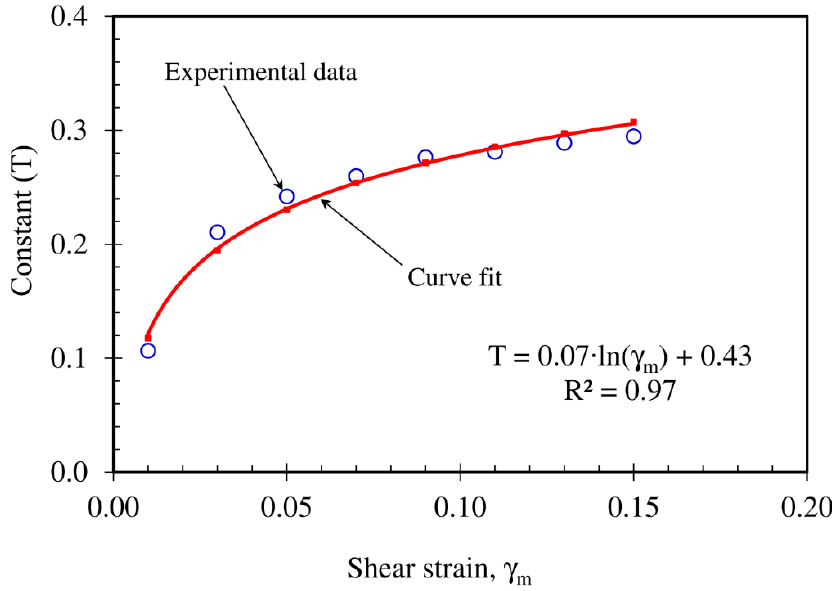
Figure 6. Variation trend of T as a function of the monotonic shear strain ( γ m ).